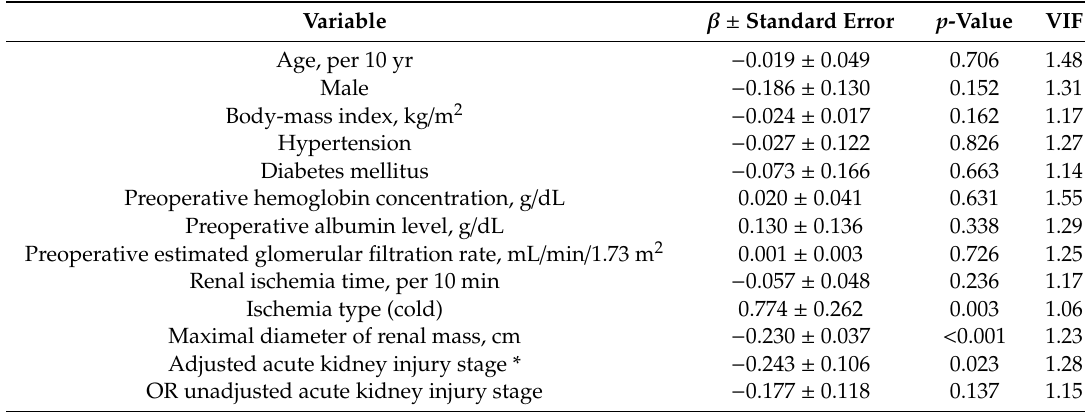
Table 3. Multivariable linear regression analysis of functional recovery from ischemia at 3–12 months after partial nephrectomy.